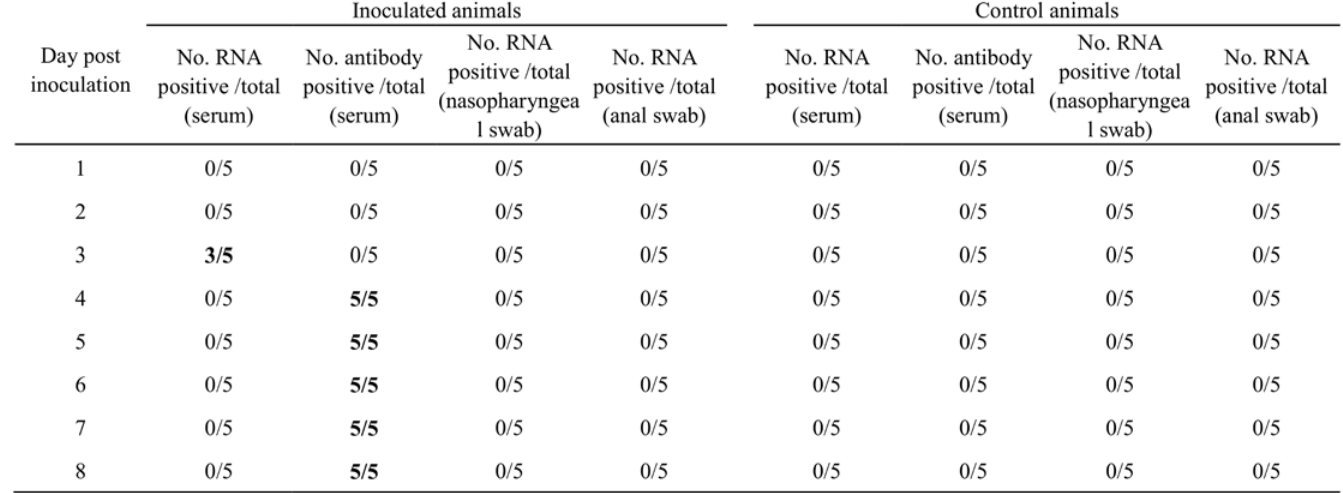
Fig 2. SFTSV RNA and specific antibodies detected in goats in experimental infection